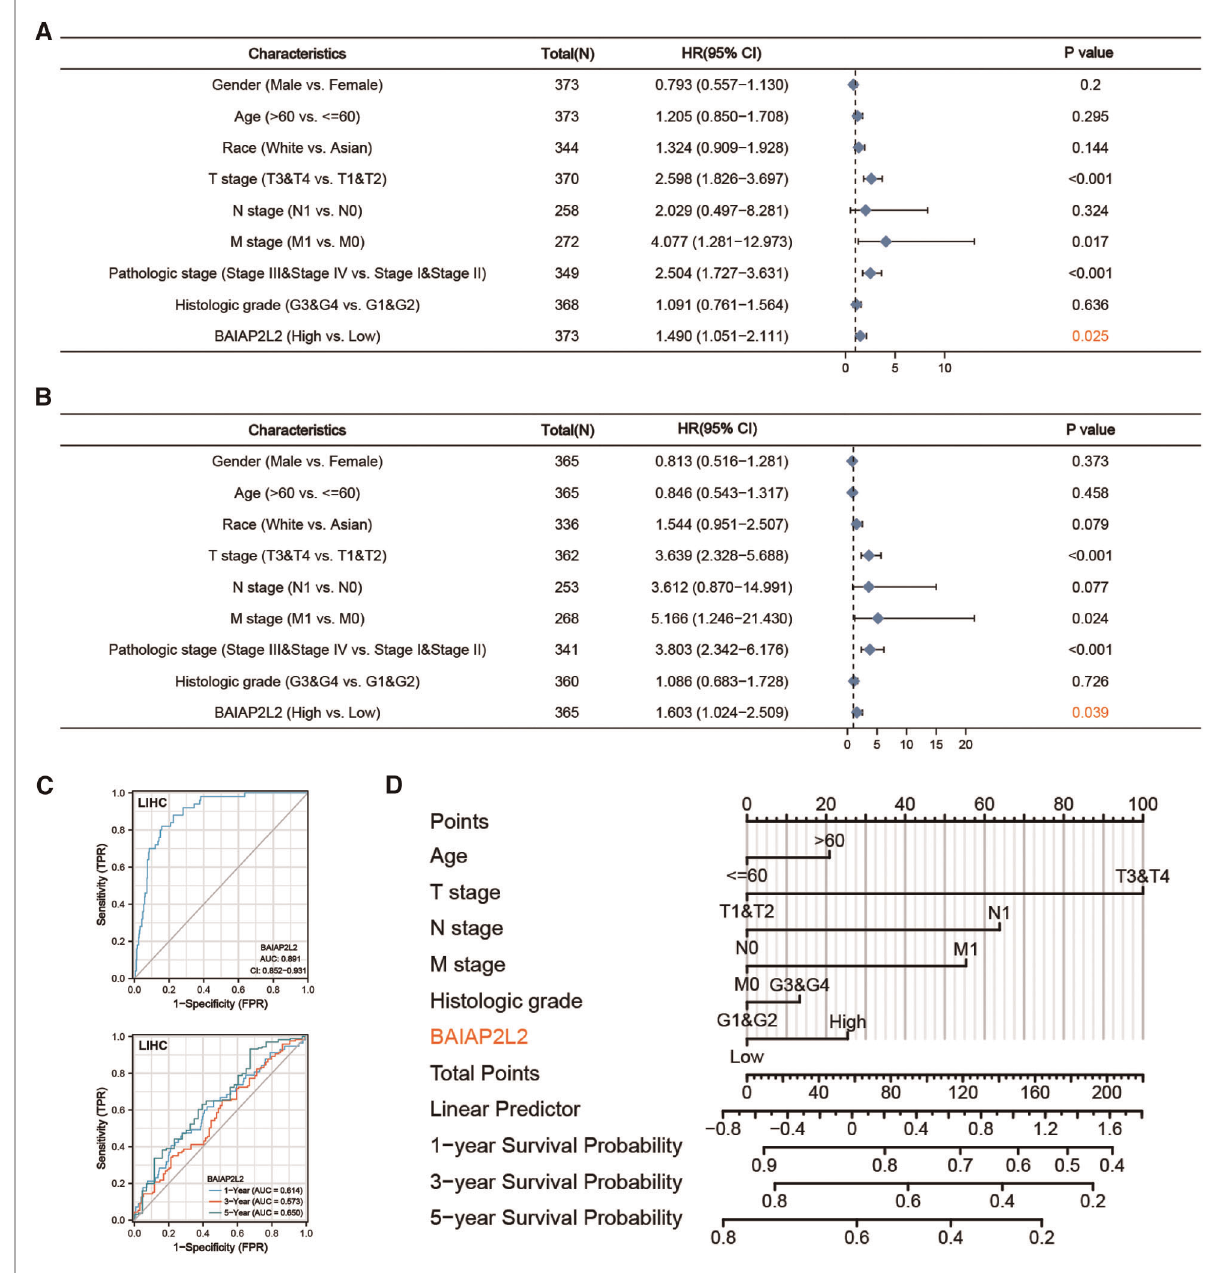
FIGURE 6 Forest plot, ROC curve and nomogram. ( A ) Forest plot of the Cox regression analysis in TCGA-LIHC (OS). ( B ) Forest plot of the Cox regression analysis in TCGA-LIHC (RFS). ( C ) ROC curve and time-dependent ROC curve for BAIAP2L2 in LIHC samples and adjacent Normal tissue samples from TCGA. ( D ) A nomogram for predicting the 1-, 3- and 5-year survival probability of